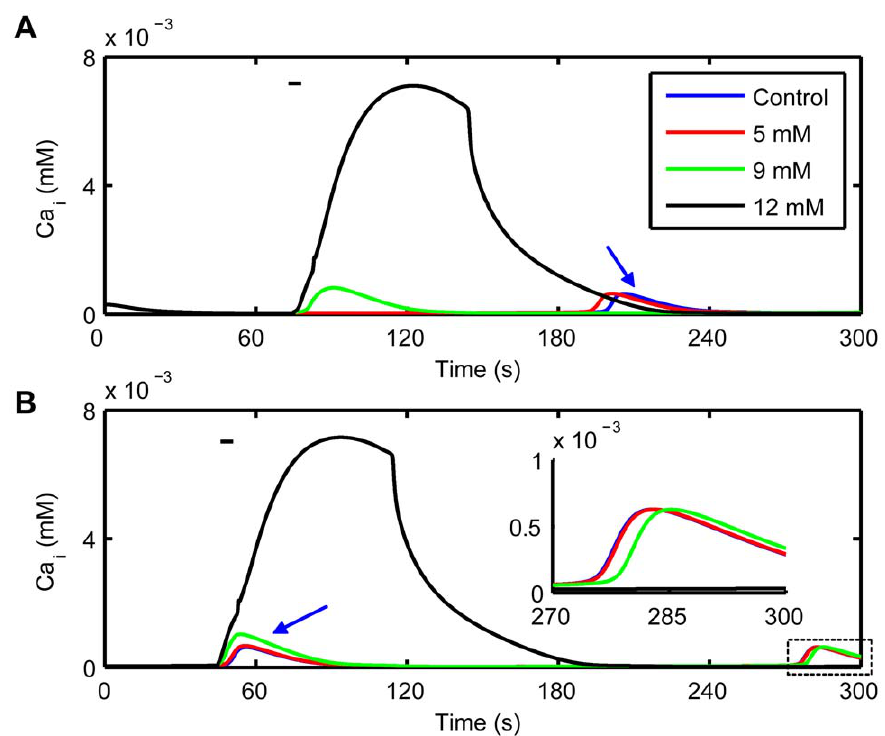
Figure 6. Transition from CASs to CSDCWs. (A) By locally increasing K o to 5 or 9 mM, Ca 2 + in ICS is increased, which facilitates the occurrence of CASs. When K o is increased to 12 mM, a CSDCW is induced. (B) Increasing K o in the present of CASs elevates Ca 2 + in ICS and then the elevated Ca 2 + will postpone the occurrence of the following CASs. Following oscillations are shown in the illustration. The bar illustrates the time of locally elevating K o , the concentrations of which are shown in the legend. Arrows indicate the appearance time of CASs under the control condition.